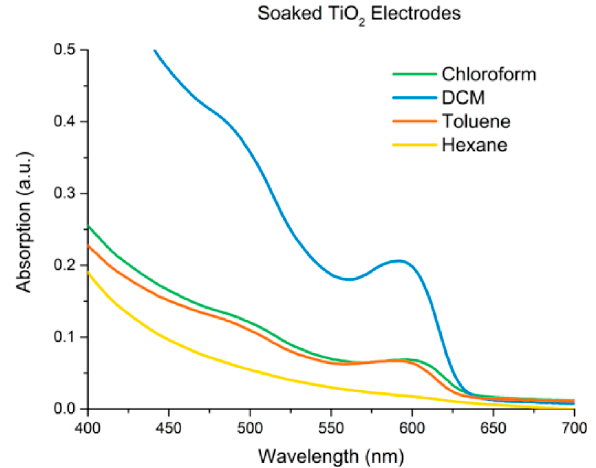
Figure 7. UV/Vis absorption spectra after soaking identical TiO 2 layers in solutions of oleic acid capped CdSe colloidal quantum dots. From [74], originally published under a CC-BY